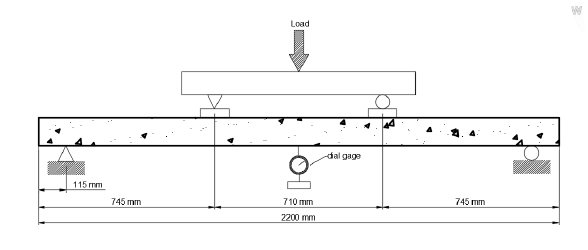
Figure 9: Flexure